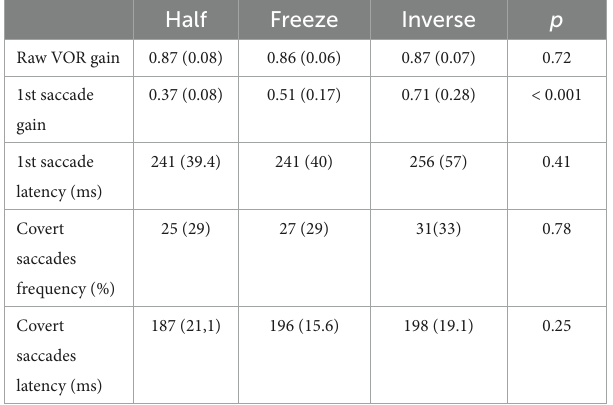
TABLE 2 Effect of altered visual conditions on different oculomotor